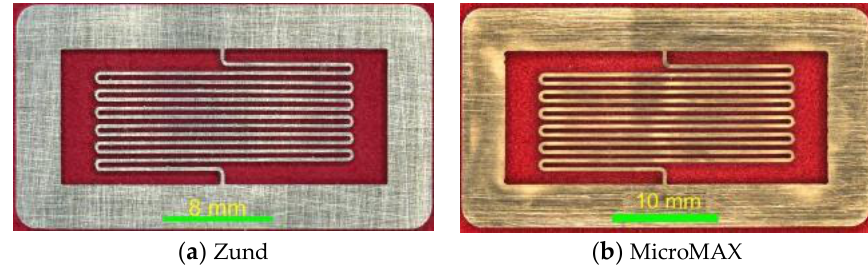
Figure 6. 0.5 scale aluminum flexures.